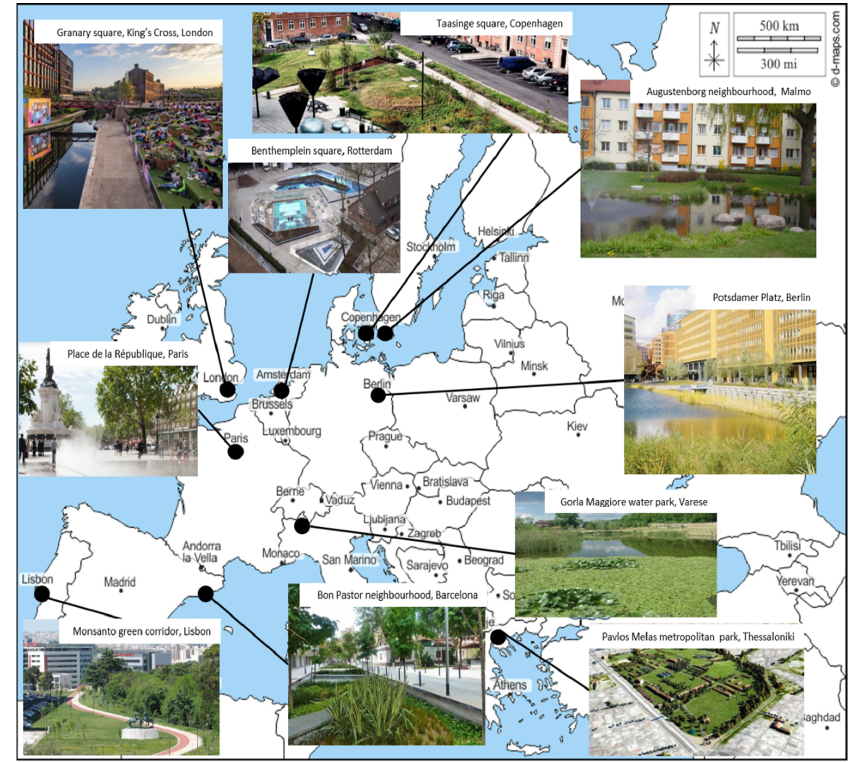
Figure 2. Geographical location and design of the case studies. Source: Own elaboration from d-maps.com (accessed on 4 June 2022) and pictures by the European Climate Adaptation Platform, Climate- ADAPT, GRaBS Project (Augustenborg neighbourhood, Malmo, Sweden); State of Green (Taasinge Square, Copenhagen, Denmark); PublicSpace.org (accessed on 4 June 2022), CCCB (Benthemplein Square, Rotterdam, Netherlands); Atelier Dreiseitl (Potsdamer Platz, Berlin, Germany); King’s Cross Business Partnership Limited (Granary Square-King’s Cross, London, United Kingdom); Architizer.com (accessed on 5 June 2022) (Place de la R é publique, Paris, France); EU OpenNESS project (Gorla Maggiore water park, Varese, Italy); EU Connecting Nature project (Pavlos Melas metropolitan park, Thessaloniki, Greece); [52] (Bon Pastor neighbourhood, Barcelona, Spain); Architects Council of Europe (Monsanto green corridor, Lisbon,